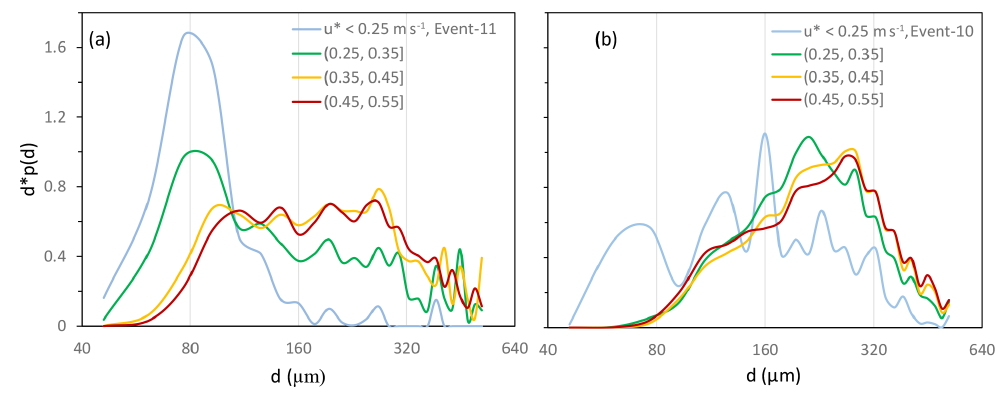
Figure 7. (a) Saltation PSD averaged for four different u ∗ categories for Event-11; (a) same as (a) but for Event-10.